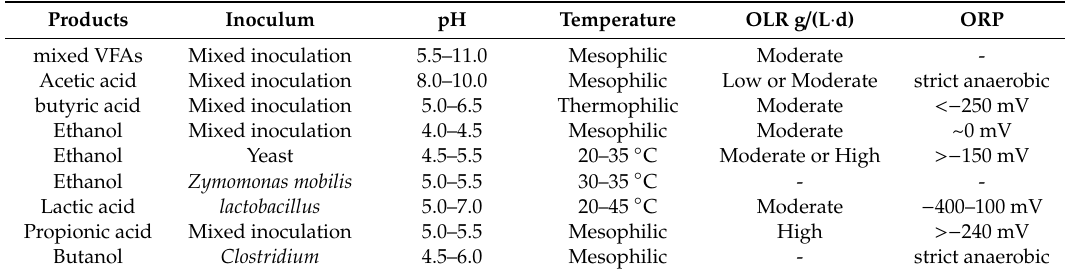
Table 3. Optimal conditions for food waste fermentation towards di ff erent products.